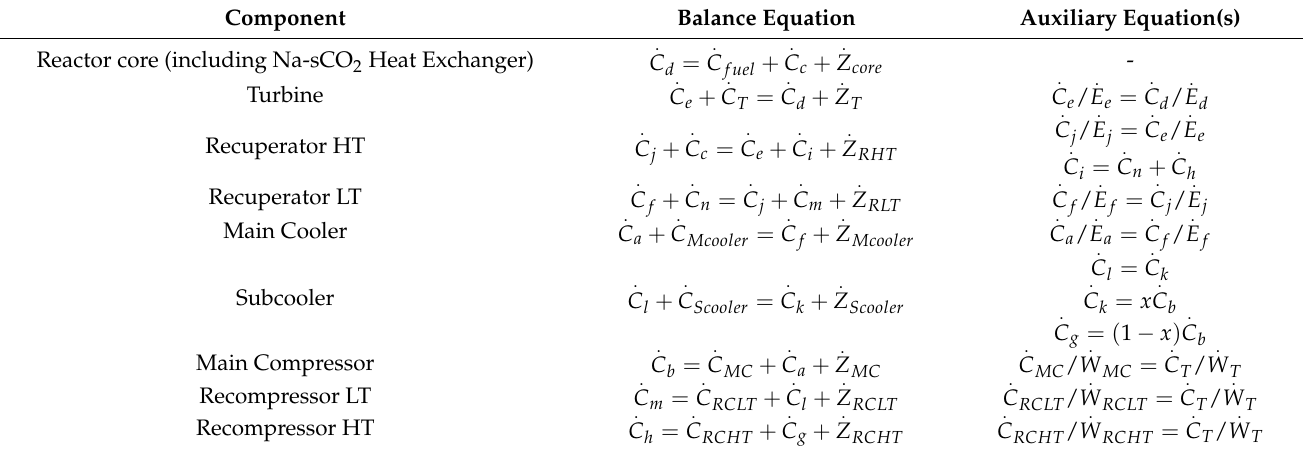
Table 3. Exergetic cost rate balance and auxiliary equations for the partial-cooling